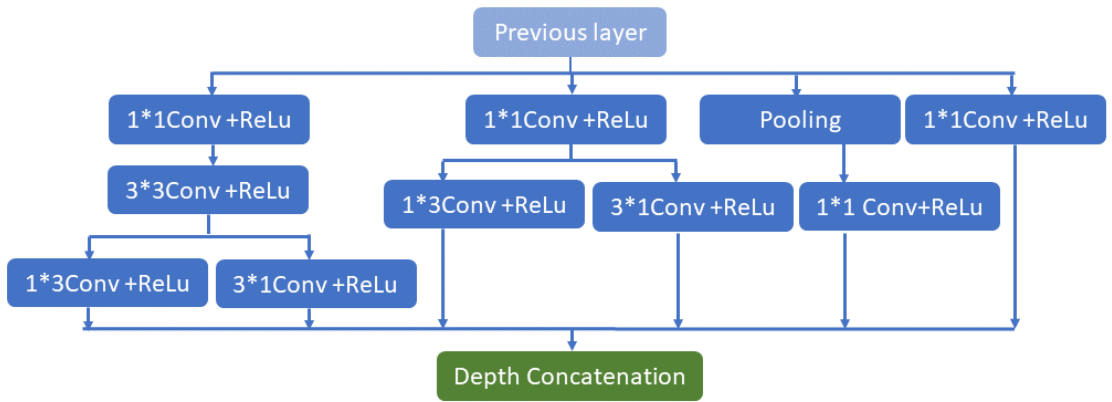
Figure 2. Inception V2 network architecture.